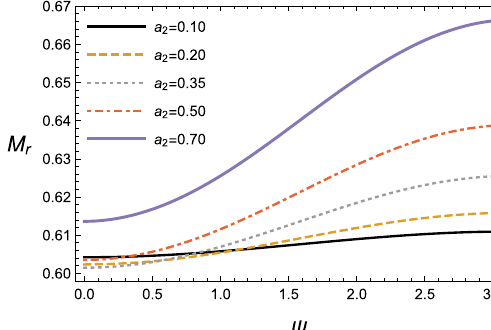
( a ) The bounds for a 2 at the different a 1 under ρ = − 1, g = 0 . 5, M 1 = 1, and M 2 = 1. Fig. 10 The upper bound on the gravitational radiation for a negative ρ